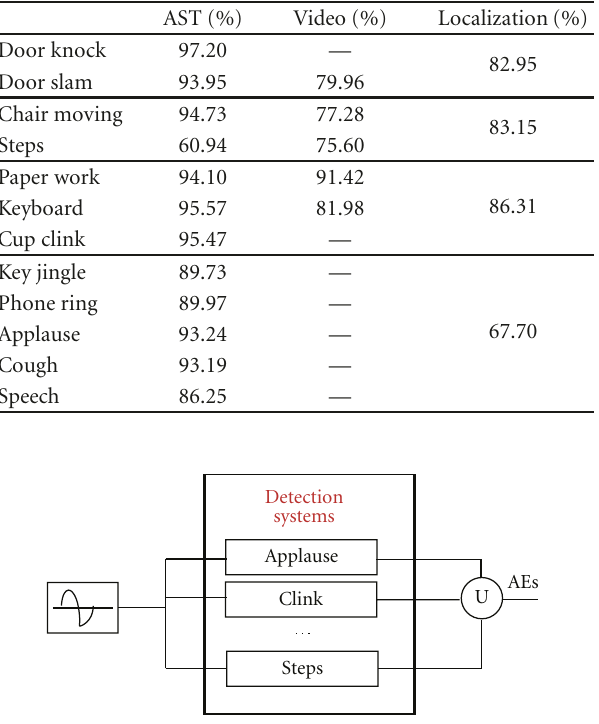
(2) The tradeo ff between the number of misses and false alarms can be optimized for each particular AE class. (3) In the case of overlapped AEs, the proposed system can provide multiple decisions for the same audio